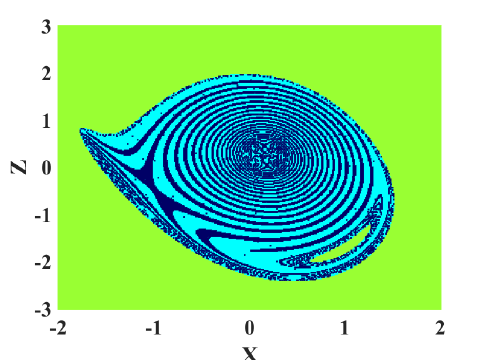
Figure 8. Basin of attraction of the oscillator; green, dark blue, and cyan regions show the basin of attraction for unbounded, periodic, and chaotic solutions,